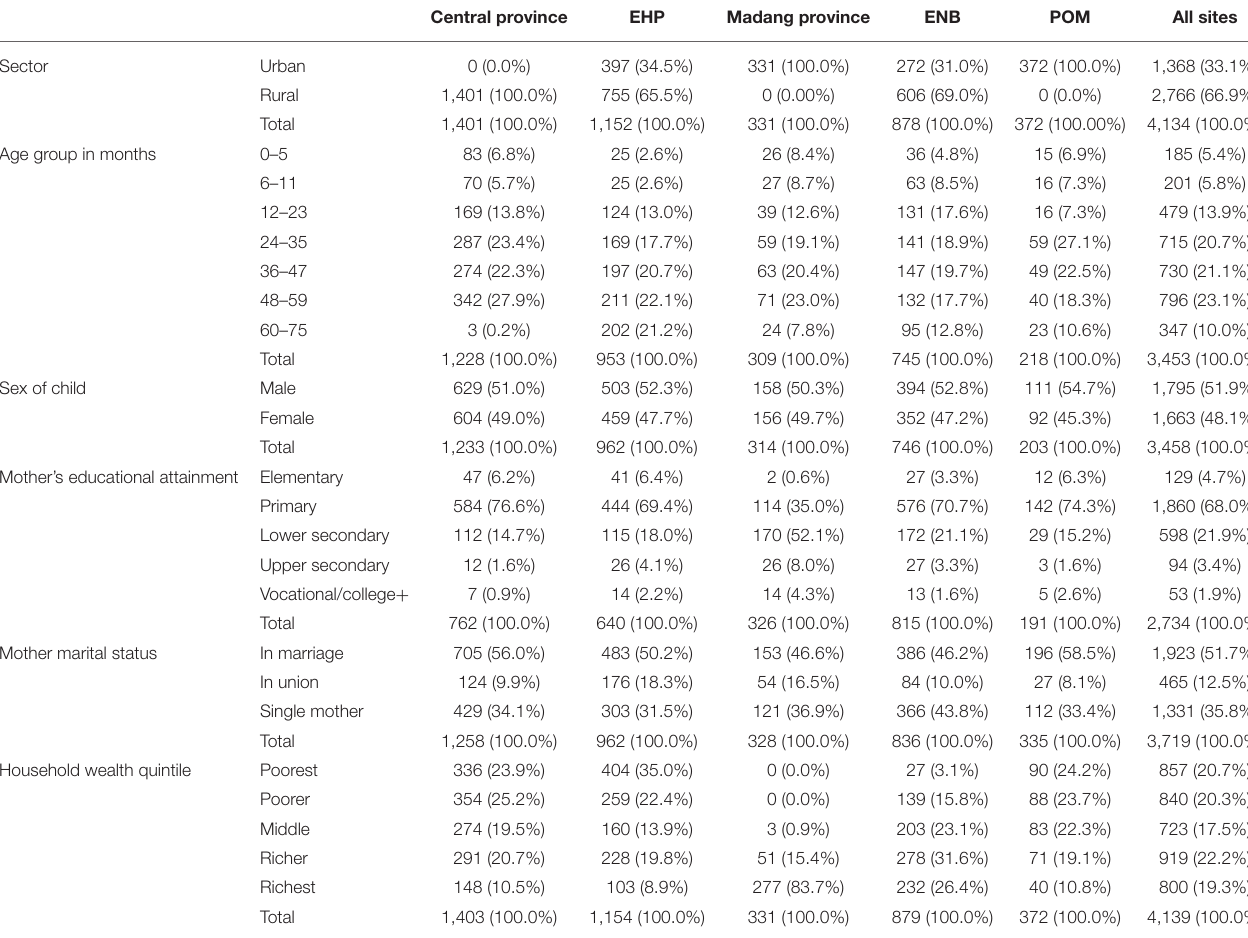
TABLE 1 | Sociodemographic characteristics of all child participants and their mothers by surveillance site, PNGIMR’s CHESS, 2020. Central